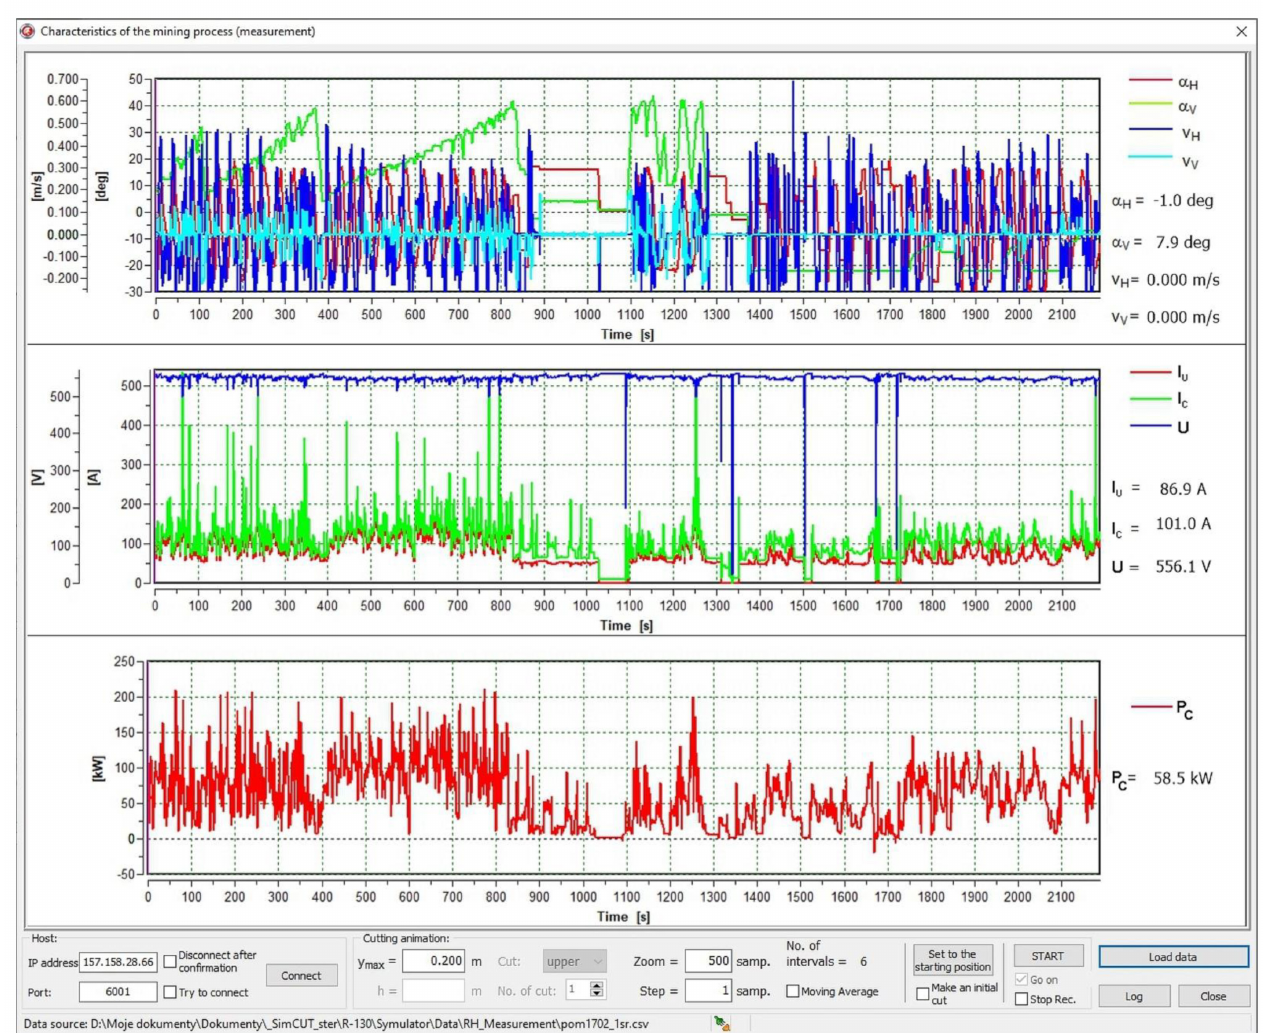
Figure 7. Data Processing Module window (Client application) with loaded data from measurements: α H , α V —boom deflection angle in the horizontal and vertical plane, v H , v V —speed of displacement of the cutting heads in the horizontal and vertical plane, I U —current engine in the cutting heads drive, I C —roadheader power supply current, U —roadheader power supply voltage, P C —power consumed by the